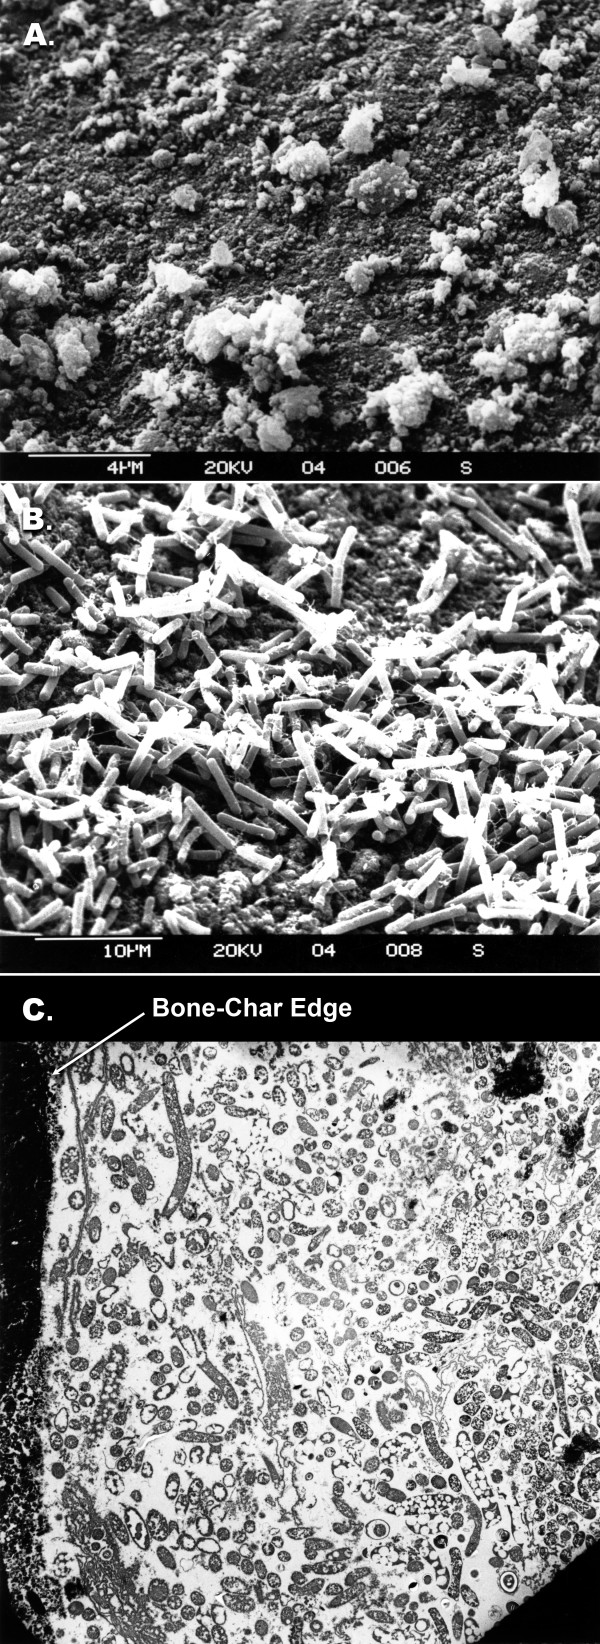
Scanning electron micrograph of adsorbed cells of C. acetobutylicum P262 onto bonechar. a) bonechar (magnification 5500); b) adsorbed cells onto bonechar (magnification 2200); c) transmission electron micrograph of adsorbed cells (magnification 2300). Similar figures (3b, c) with different magnification were published previously in the following article: Qureshi N, Paterson AHJ, Maddox IS: Model for continuous production of solvents from whey permeate in a packed bed reactor using cells of Clostridium acetobutylicum immobilized by adsorption onto bonechar. Appl Microbiol Biotechnol 1988, 29:323–328. Figure 3 is reprinted with permission from Springer, Germany (see above article).